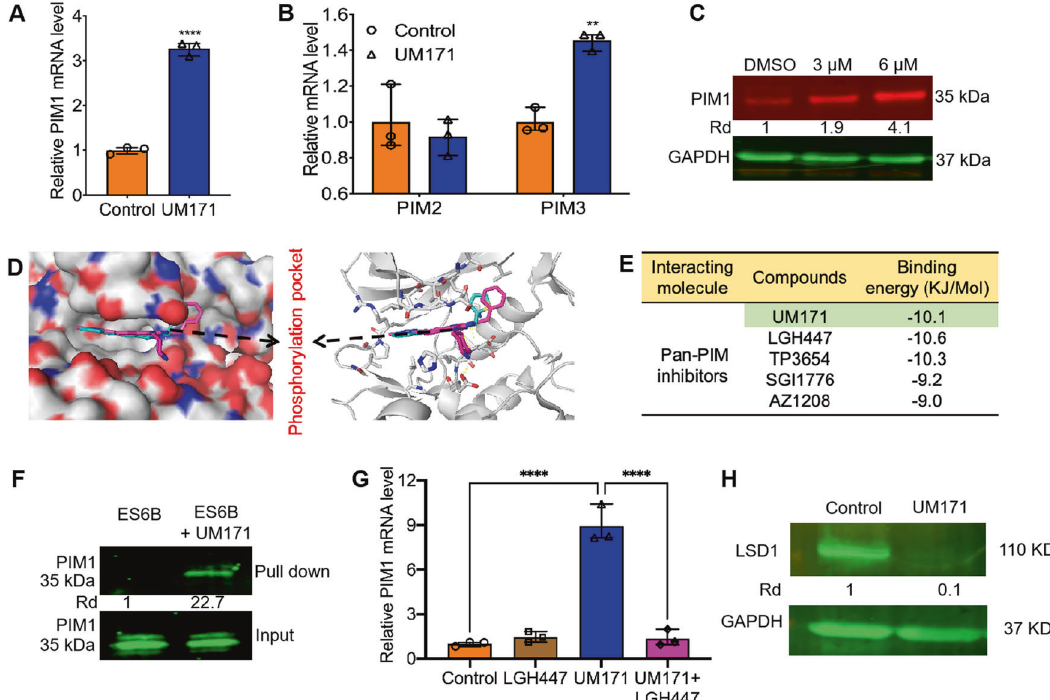
Fig. 3 UM171 binds to PIM1 and activates its phosphorylation. A Q-RT-PCR analysis of HEL cells treated with UM171 (6 μ M) for expression of the PIM1 . B Q-RT-PCR analysis of HEL cells treated with UM171 (6 μ M) for expression of the PIM2 , and PIM3 genes. C Western blot of HEL cells treated with the indicated concentration of UM171 compound. GAPDH was used as a loading control. D Molecular docking of the compound UM171 and PIM1 (PDB:5O12). The phosphorylation site of PIM1 kinase was shown as insert. E The molecular binding energy between PIM1 and UM171 as well as pan-PIM inhibitors LGH447, TP3654, SGI1776 ad AZ1208. F Binding of PIM1 to UM171 in pull-down experiment using af fi nity ES6B beads. G Q-RT-PCR analysis of HEL cells treated with UM171 (6 uM), LGH447(5 μ M), and UM171 + LGH447 for 24 hours for expression of PIM1. H Western blot of HEL cells treated with UM171 and DMSO for expression of